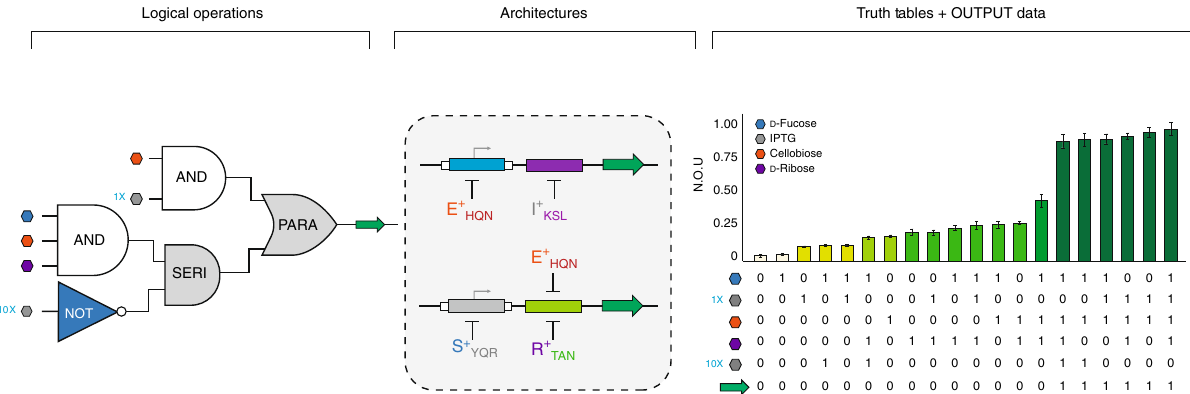
Fig. 8 A complex program via the master architecture. Arranging two SERI structures in a PARA con fi guration leads to the development of the genetic master circuit. This con fi guration employs four non-synonymous DNA operators and allows for the generation of any of the logical programs presented in this study. When both outputs are the same (GFP), this gives rise to the most granular digital-to-analog converter in this study. The top channel contains two operators arranged in a SERI architecture and therefore functions as a digital-like AND gate with respect to cellobiose and IPTG. By capitalizing on off- diagonal interactions, the bottom channel becomes a three-signal AND gate with respect to the ligands D -fucose, D -ribose, and cellobiose. Finally, we take advantage of the ligand overlap between GalS and LacI to generate additional output states with varying GFP outputs. Values represent the mean of n = 12 biological replicates and error bars indicate the 95% CI or ~2x s.e.m. Y -axis is given as normalized output units or N.O.U. This is calculated by taking GFP fl uorescence (485ex., 510em.) normalized to OD 600 , which is further normalized to the maximum output for each experiment. Source data provided as a Source Data File and individual data points overlaid as dot plots can be found in Supplementary Fig.